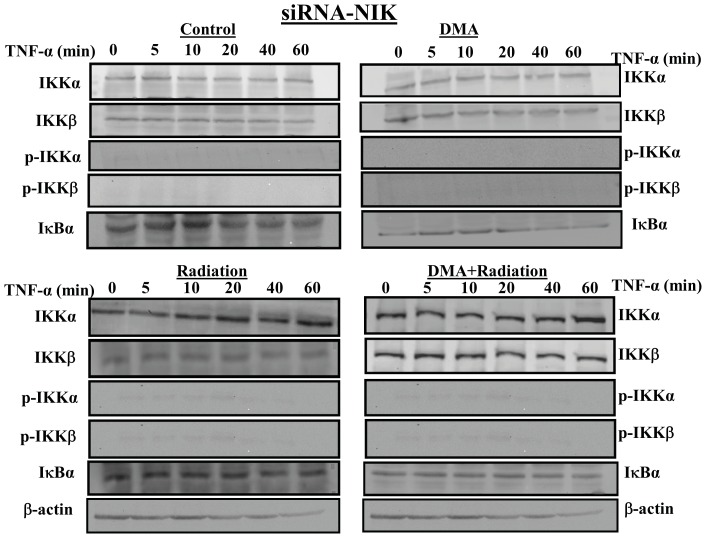
Effect of transfection with siRNA-NIK on the phosphorylation of IKKα and IKKβ.U87, human glioma cells were transiently transfected with siRNA-NIK. Phosphorylation of IKKα, IKKβ was absent concurrent with equivalent expression of IκBα in response to both DMA and radiation treatment.